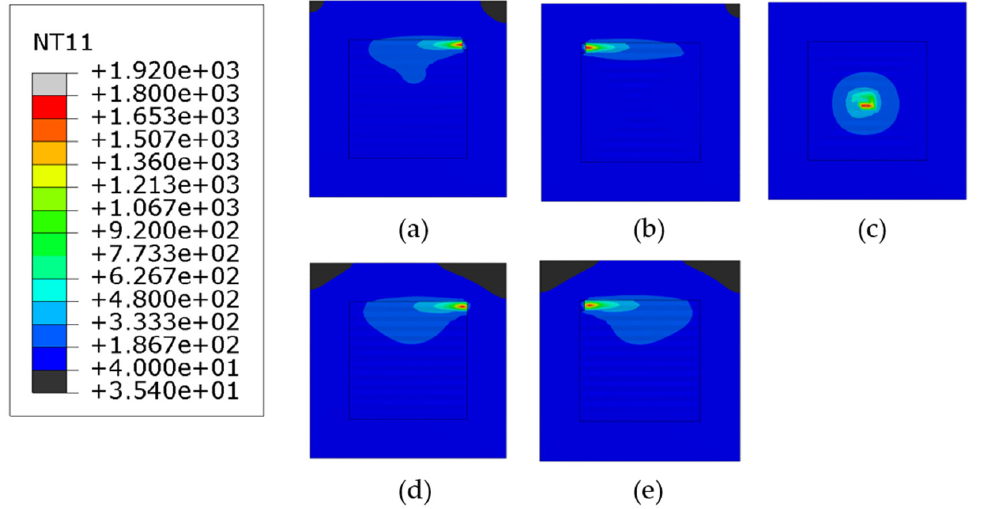
Figure 6. The temperature distributions of all patterns considered at the end of deposition process ( a ) alternate, ( b ) in–out, ( c ) out–in, ( d ) raster, ( e ) zigzag (Top view, unit: °C).